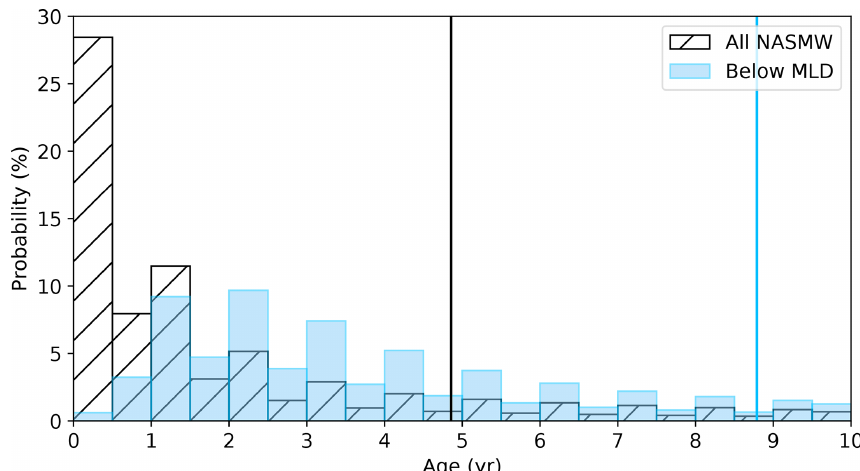
Figure 10. Probability distribution of model NASMW age (hatched bars) and age of NASMW restricted to be found below the mixed layer depth (blue bars). The percentage of the NASMW budget formed in a given 0.5-year bin is indicated by its associated bar. The expected value of the distribution is marked by a solid line.